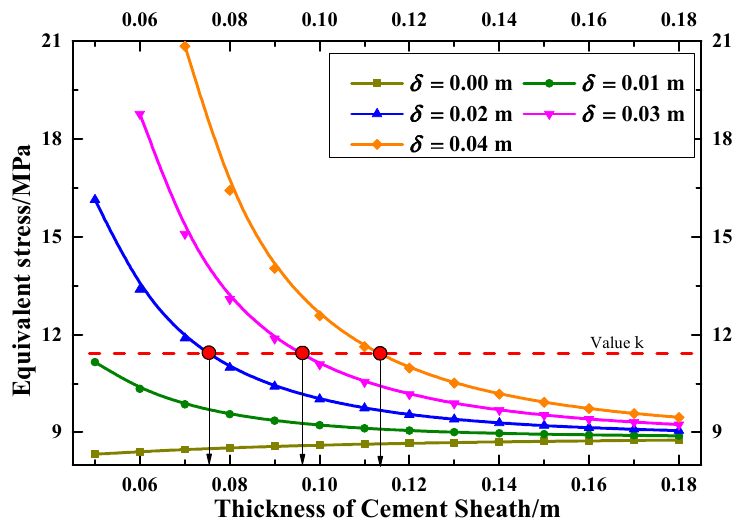
Figure 14. Variation of the equivalent stress of the cement sheath with the increase of cement thickness.